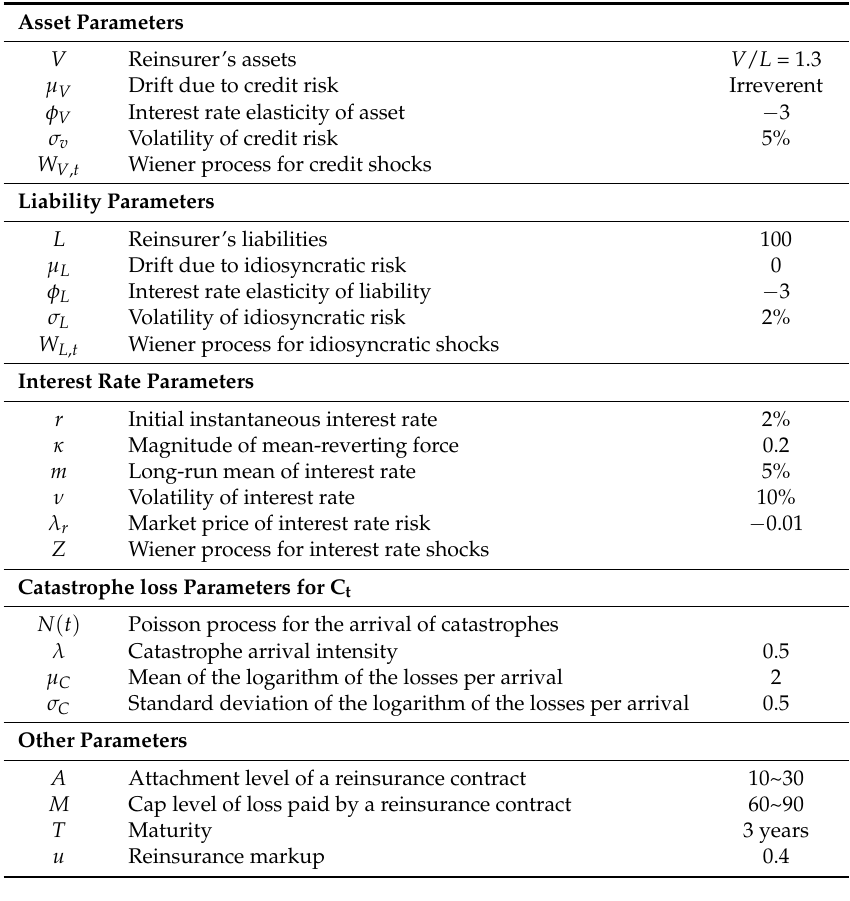
Table 1. Parameter Definitions and Base